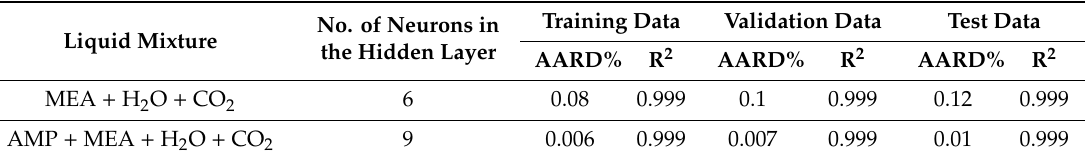
Table 4. Performance of trained artificial neural networks (ANNs) for density. Liquid